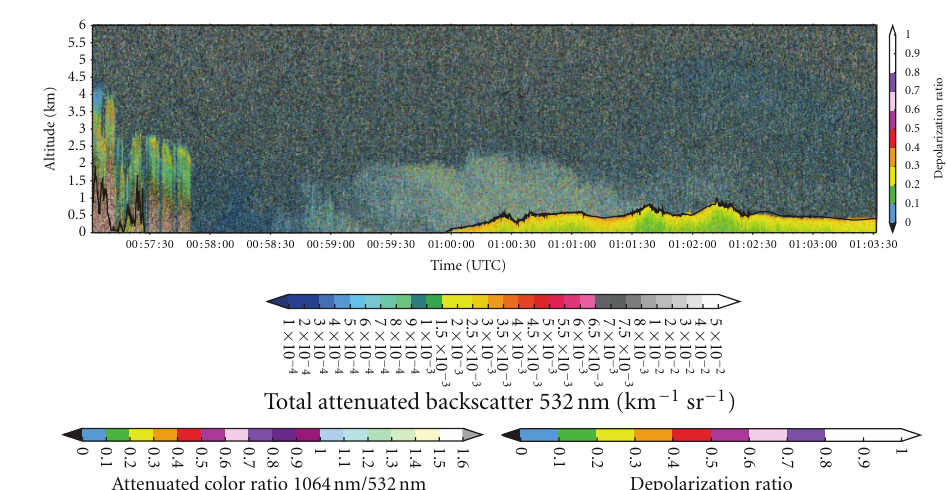
(b) Attenuated color ratio (ACR or c-ratio: 1064/532nm)